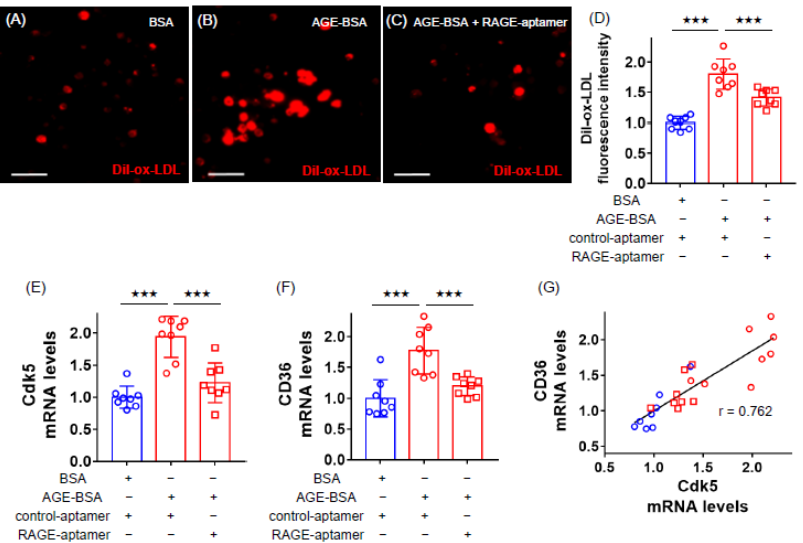
Figure 1. Effects of RAGE-aptamer on Dil-ox-LDL uptake, Cdk5 and CD36 gene expression in advanced glycation end product (AGE)-exposed U937 cells. U937 macrophages were treated with 100 µg/mL AGE-bovine serum albumin (AGE-BSA), 100 µg/mL non-glycated BSA in the presence or absence of 100 nmol/L RAGE-aptamer, or 100 nmol/L control-aptamer in Roswell Park Memorial Institute (RPMI) 1640 medium supplemented with 10% fetal bovine serum including 100 µg/mL streptomycin and 100 U/mL penicillin at 37 °C in 5% CO 2 for 24 h. The cells then were incubated with 10 µg/mL Dil-ox-LDL in the same RPMI 1640 medium for 18 h to evaluate the fluorescence intensity. ( A – C ) Representative immunofluorescent staining images. Dil-ox-LDL-positive cells were stained in red. Scale bars represent 50 µm. ( D ) Quantitative data of fluorescence intensity. Dil-ox-LDL uptake was normalized by the control values with BSA. ( E – G ) Gene expression levels of Cdk5 ( E ) and CD36 ( F ) and their correlation ( G ). Total RNAs were transcribed and amplified by real-time PCR. Data were normalized by the intensity of GAPDH mRNA-derived signals and then related to the control values with BSA. The correlation between Cdk5 and CD36 gene expression levels was determined by Pearson’s correlation test. Number = 8 for each group. Results are presented as mean ± standard deviation. (cid:70)(cid:70)(cid:70) p < 0.005 vs. treatment of